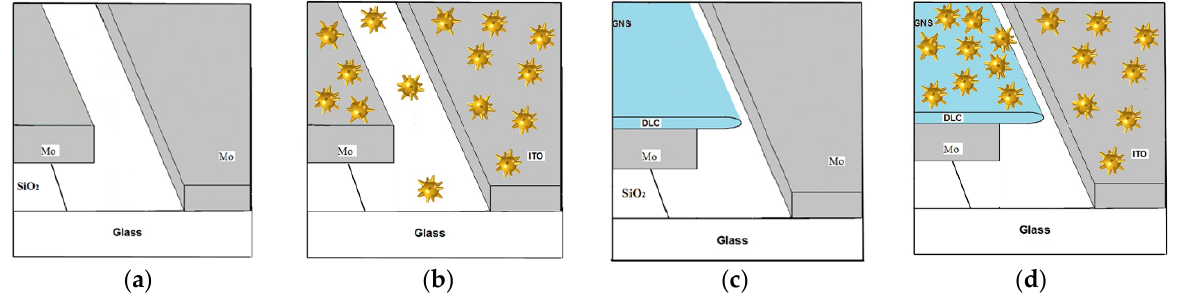
Figure 4. Structure of experimental samples: “Mo” ( a ); “Mo-GNS” ( b ); “Mo-DLC” ( c ); “Mo-DLC-GNS” ( d ).